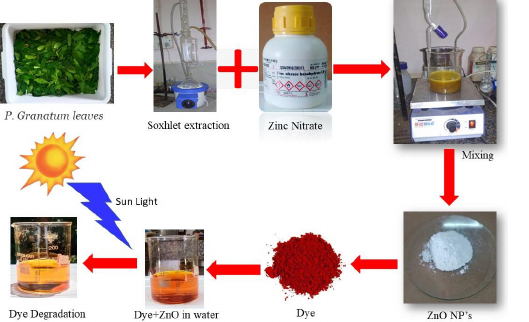
Figure 1. Step-by-step process of ZnO-NP synthesis via green route and the degradation of the dye.